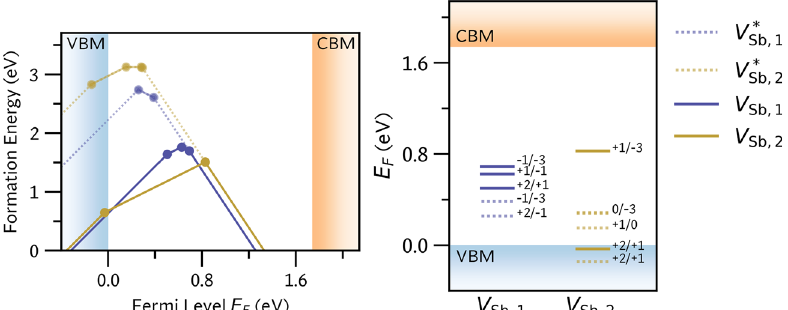
Fig. 6 Defect formation energy (left) and vertical energy level (right) diagram for the antimony vacancies in Sb 2 S 3 , under sulfur rich conditions 121 ( μ S = 0, μ Sb = − 0.55 eV). The two symmetry inequivalent sites are depicted in purple ( V Sb,1 ) and gold ( V Sb,2 ). For each site, the ground state structures are shown with solid lines ( V Sb ), while the metastable states are shown with faded dotted lines ( V (cid:3) maximum (VBM) and conduction band minimum (CBM) are shown in blue and orange,